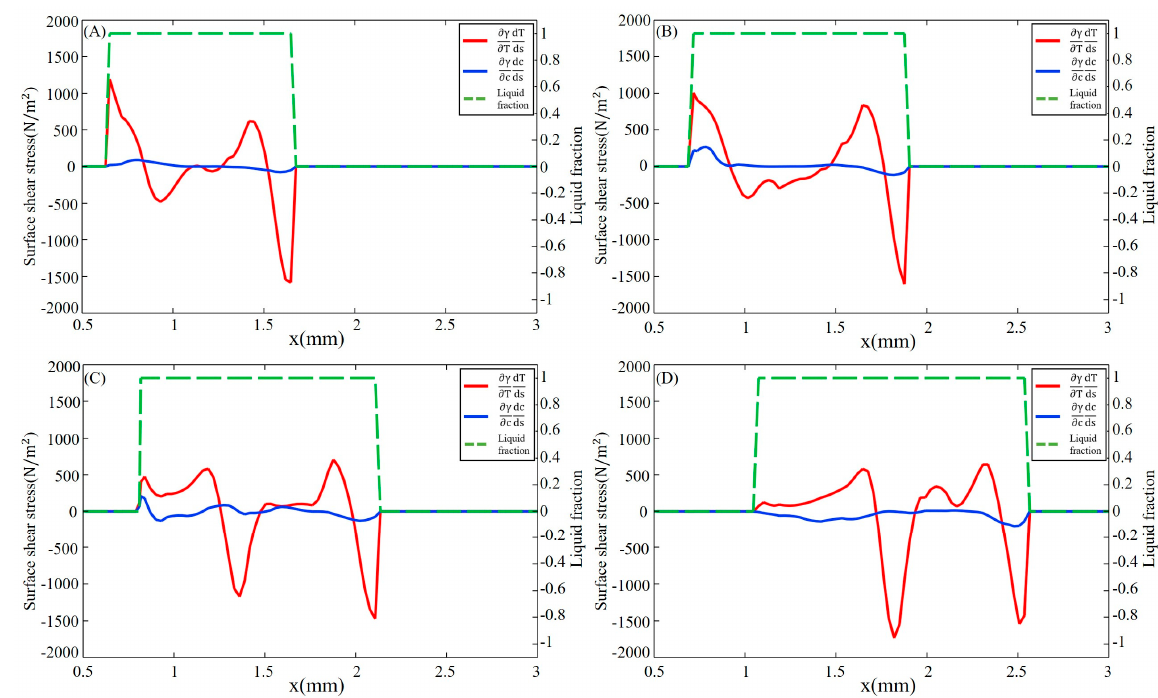
Figure 5. Surface shear stress in the longitudinal section with y = − 0.2 mm on the 304SS side at different times. ( A ) 10 ms; ( B ) 20 ms; ( C ) 30 ms; ( D ) 50 ms.